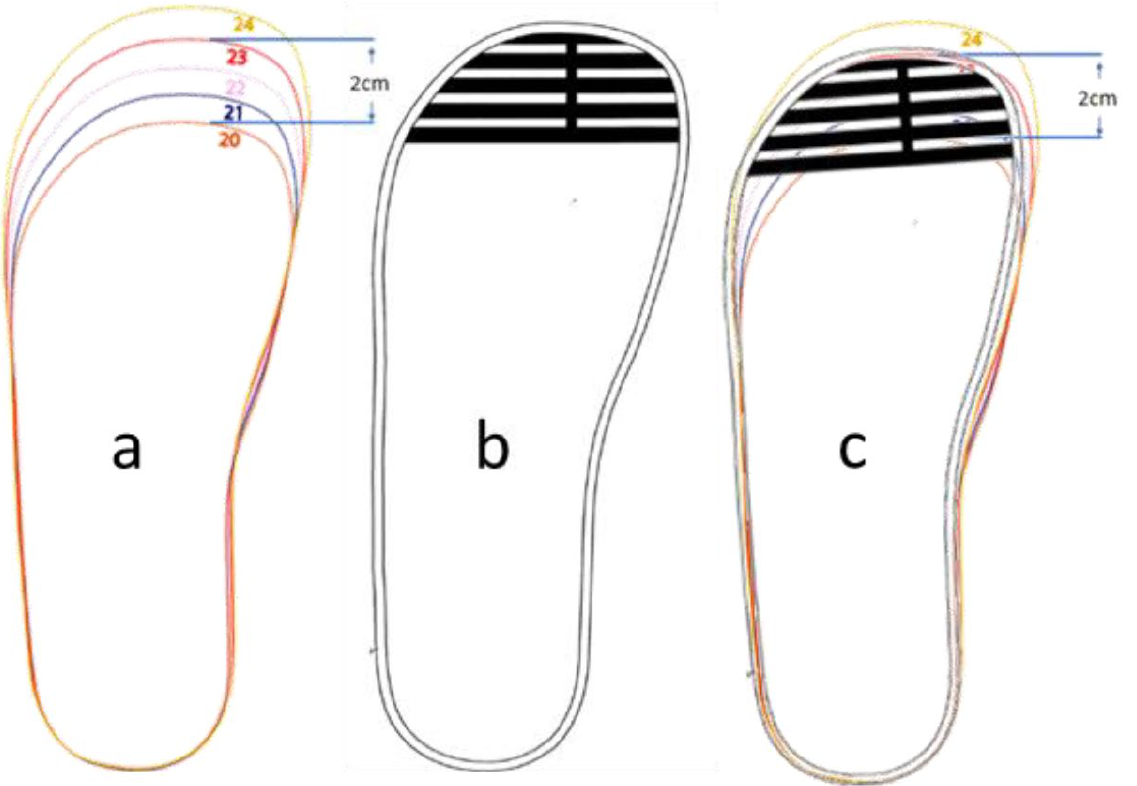
Figure 10. ( a ) Insole information from Bobux showing the 2 cm mark. ( b ) Sensor pattern segmented but connected in the middle. ( c ) Sensor pattern overlapped with insole information.